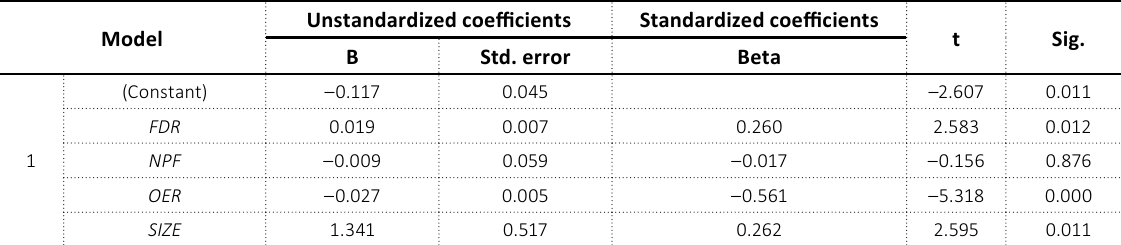
Table 11. Results of the regression analysis of the Indonesian Islamic banks